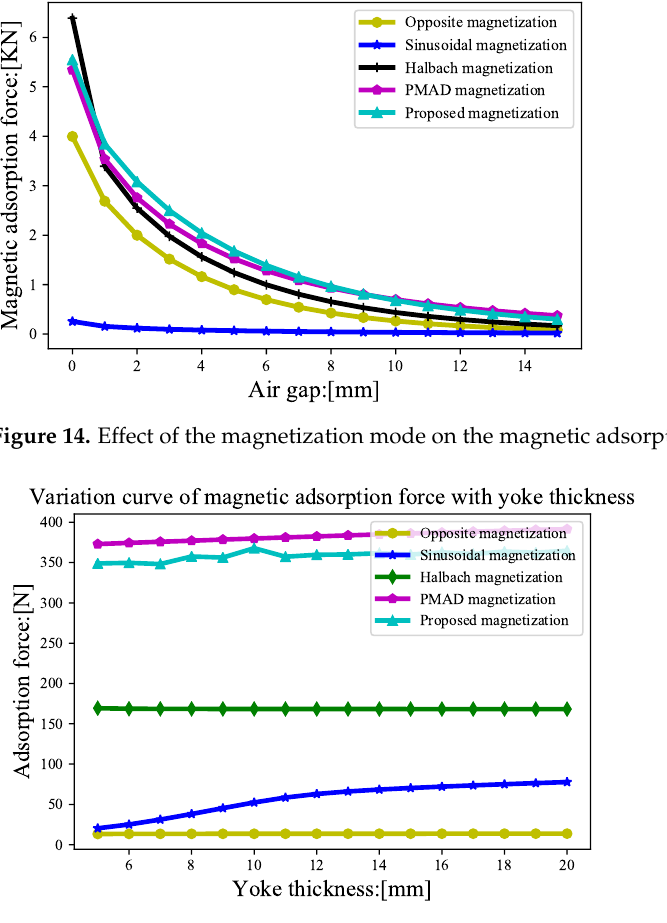
Figure 15. Effect of the yoke thickness on the magnetic adsorption force.